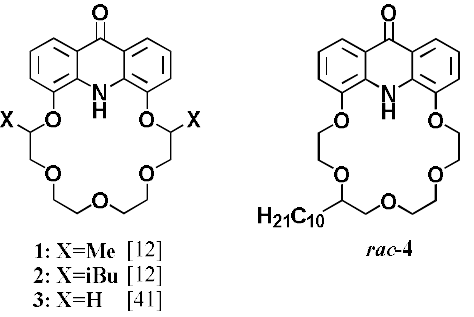
Figure 1. Macrocycles ( 1 – 3 ) possessing lead(II) ion selectivity and the newly synthesized ionophore rac - 4 .